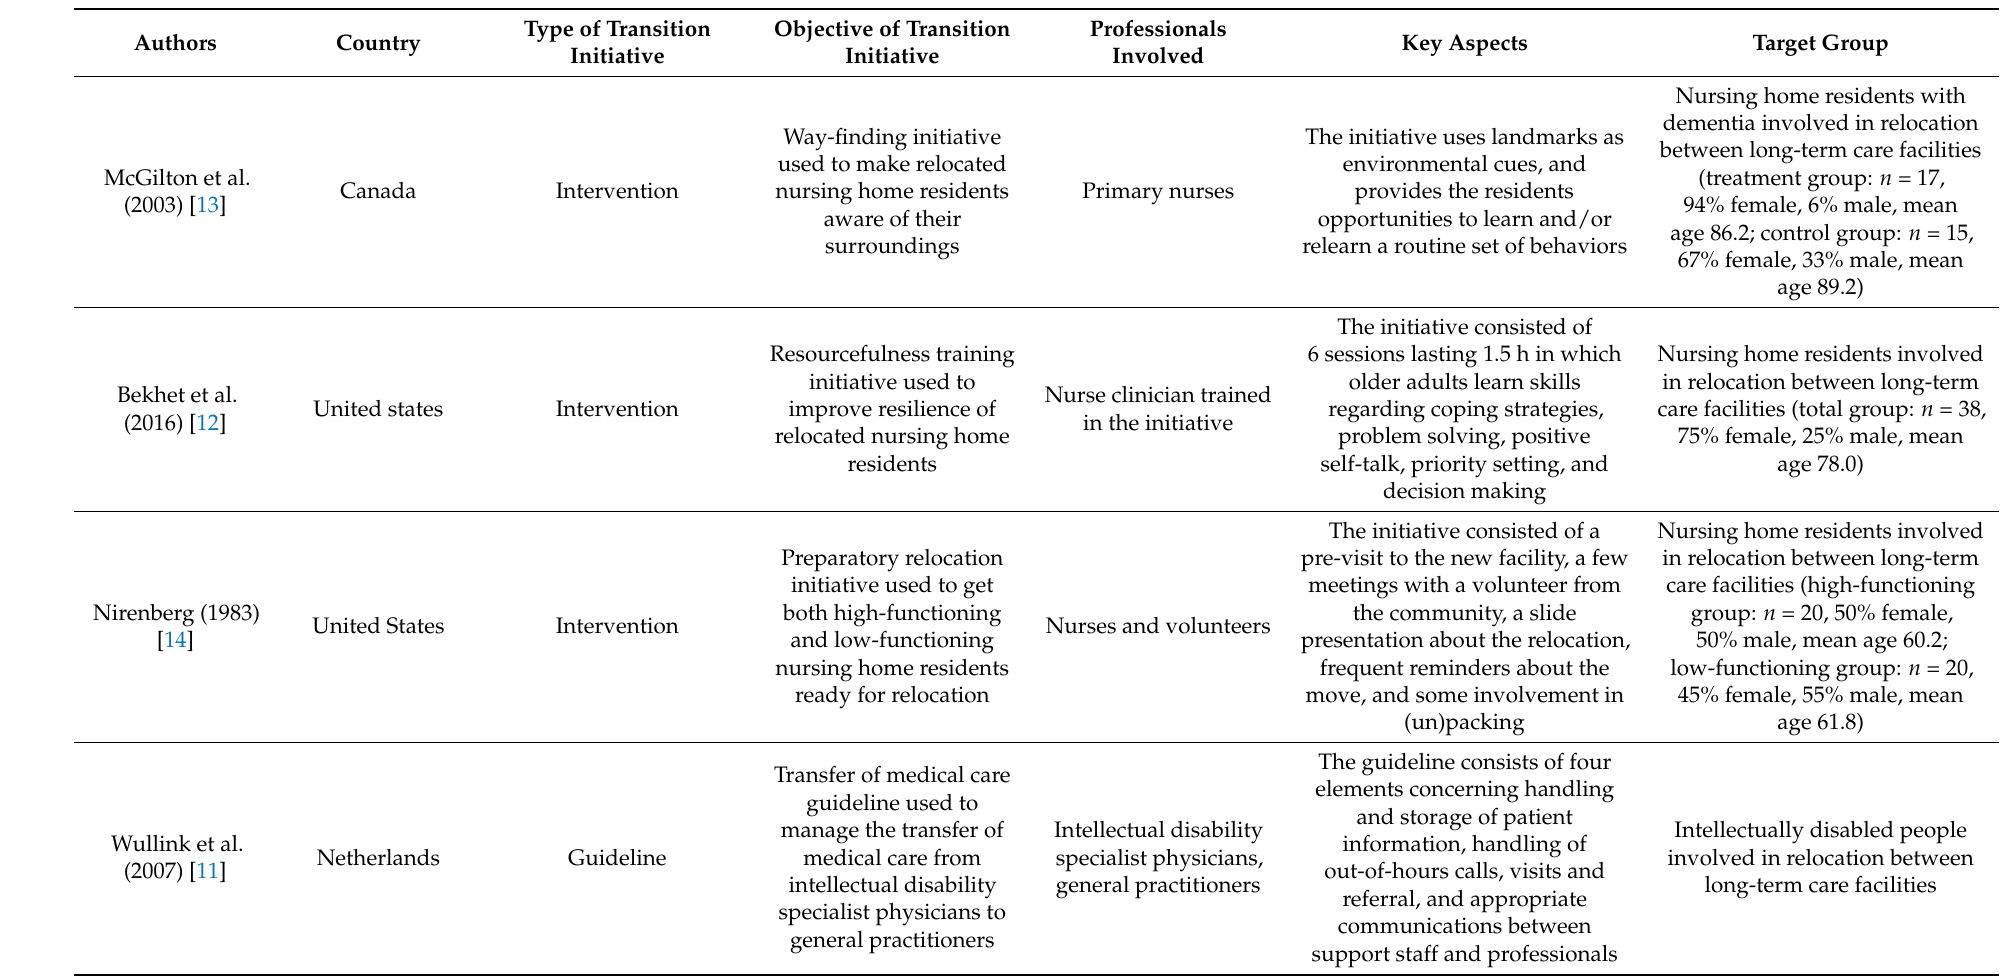
Table 2. Extraction